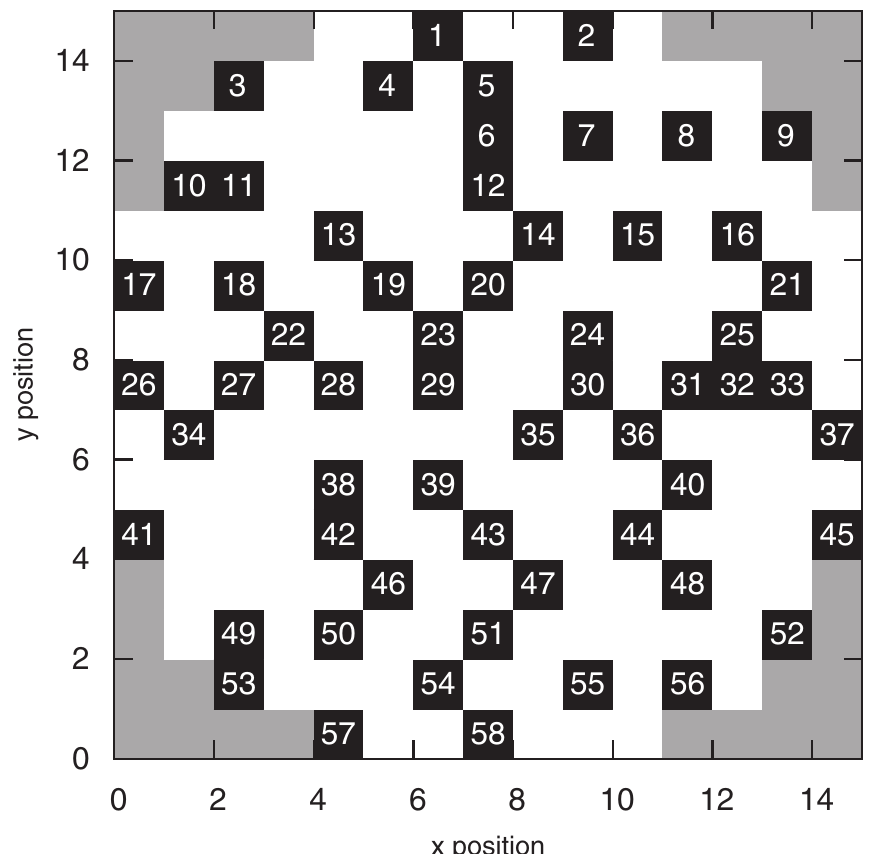
Fig. 1. The Mobile Fission Chambers (MFC) instruments within the nuclear core are localised in assemblies in black, in a horizontal slice of the core. The assemblies without instrument are marked in white, and the re fl ector is in